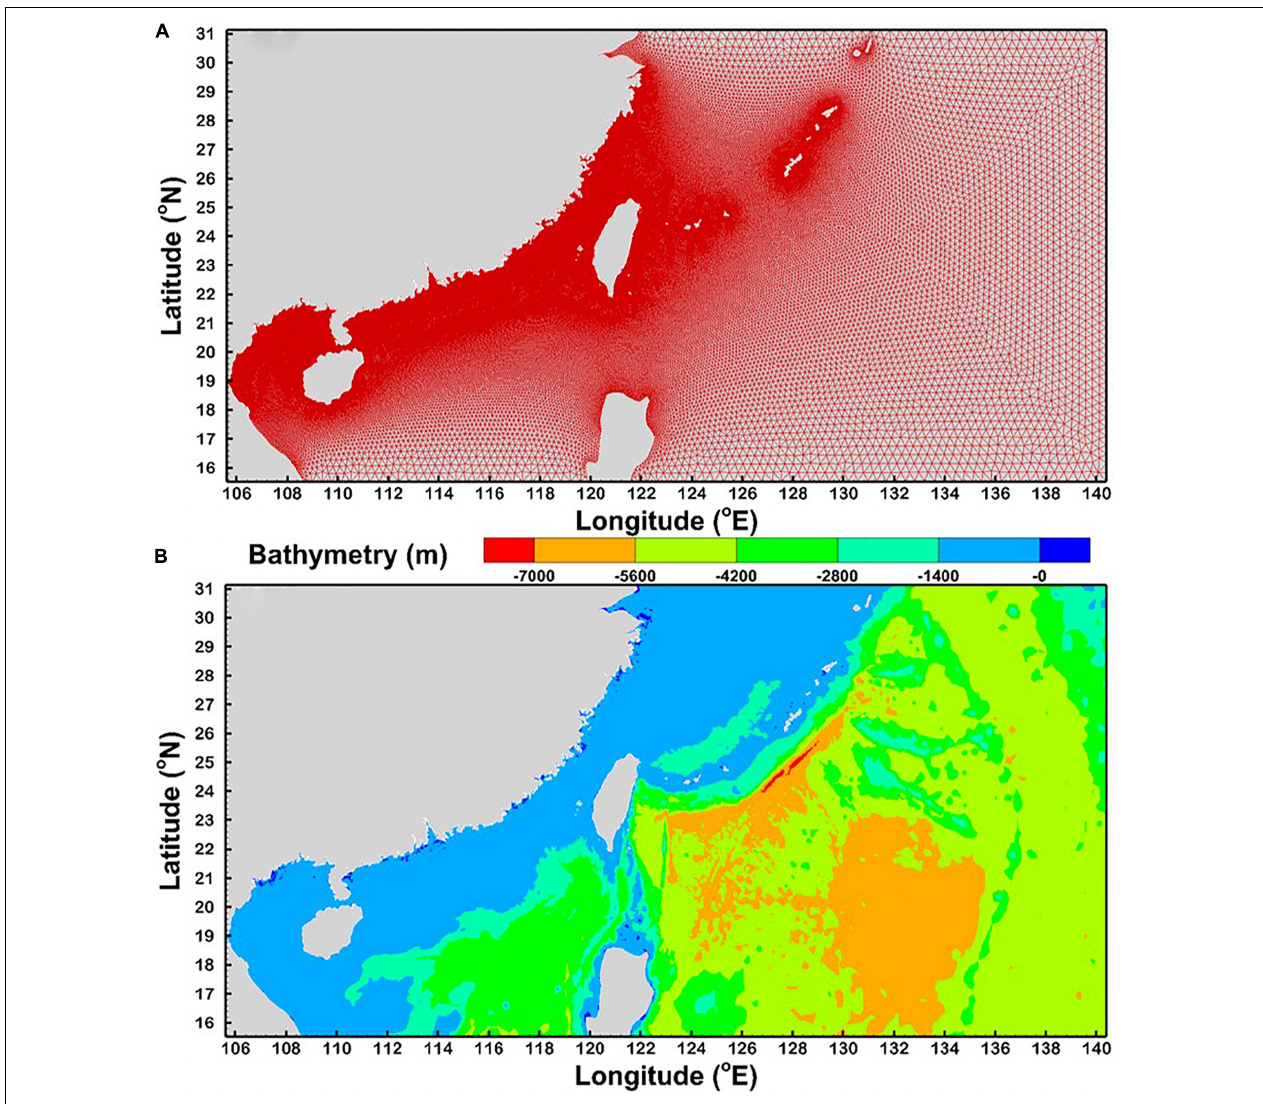
FIGURE 2 | (A) Unstructured triangular meshes and (B) bathymetry of the entire computational domain for the SCHISM-WWM-III modeling system.